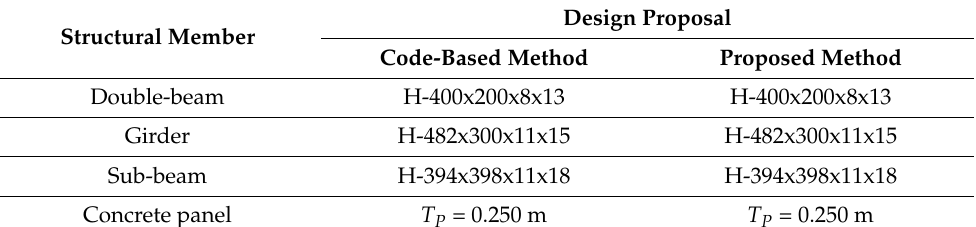
Table 2. Comparison of the optimal design proposal in steel double-beam floor system between code-based design method and proposed design method.